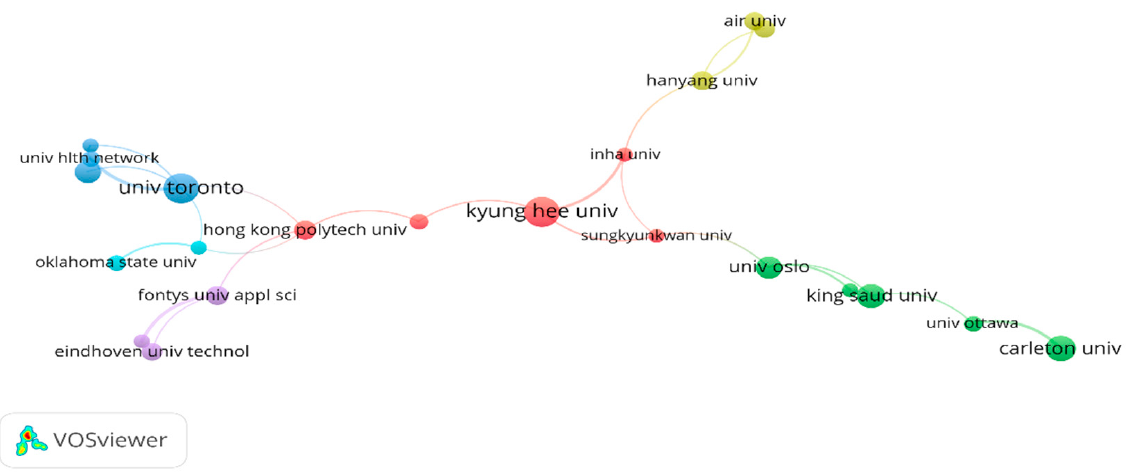
Figure 3. Network visualization by collaborative organizations.